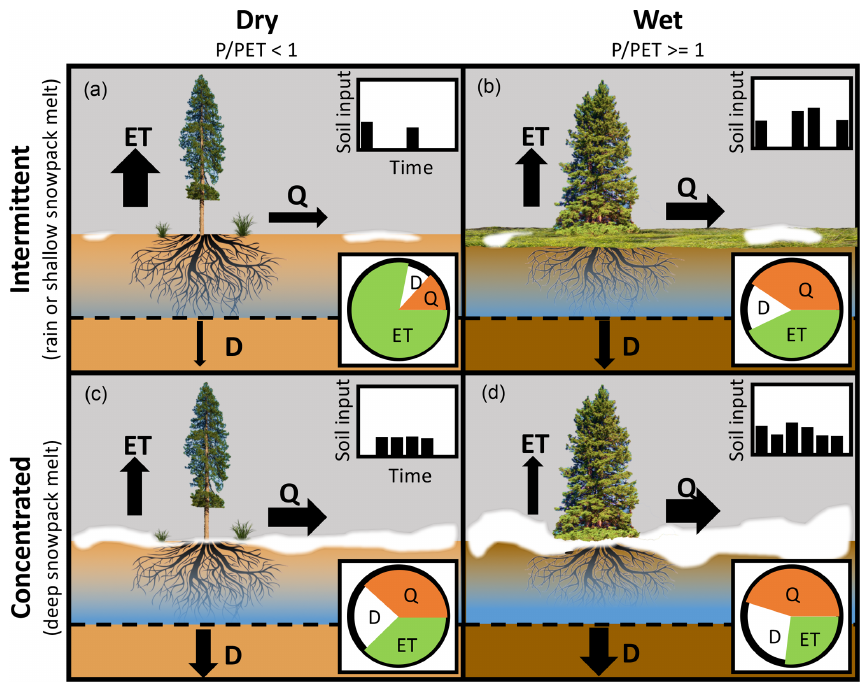
Figure 1. Conceptual illustration of study hypotheses indicating the importance of concentrated snowmelt input (c, d) vs. intermittent input (a, b) for runoff generation. The wet climate (b, d) generates more runoff ( Q ) and deep drainage ( D ) and less evapotranspiration (ET) compared to the dry climate (a, c) . In both climates, concentrated input can increase both Q and D because it is more likely to allow soil saturation than intermittent input, which allows ET during periods of drying. The concentrated input from snowmelt leads to greater increases in Q and D in the dry climate than in the wet climate because snowmelt is the most likely cause of soil saturation in dry